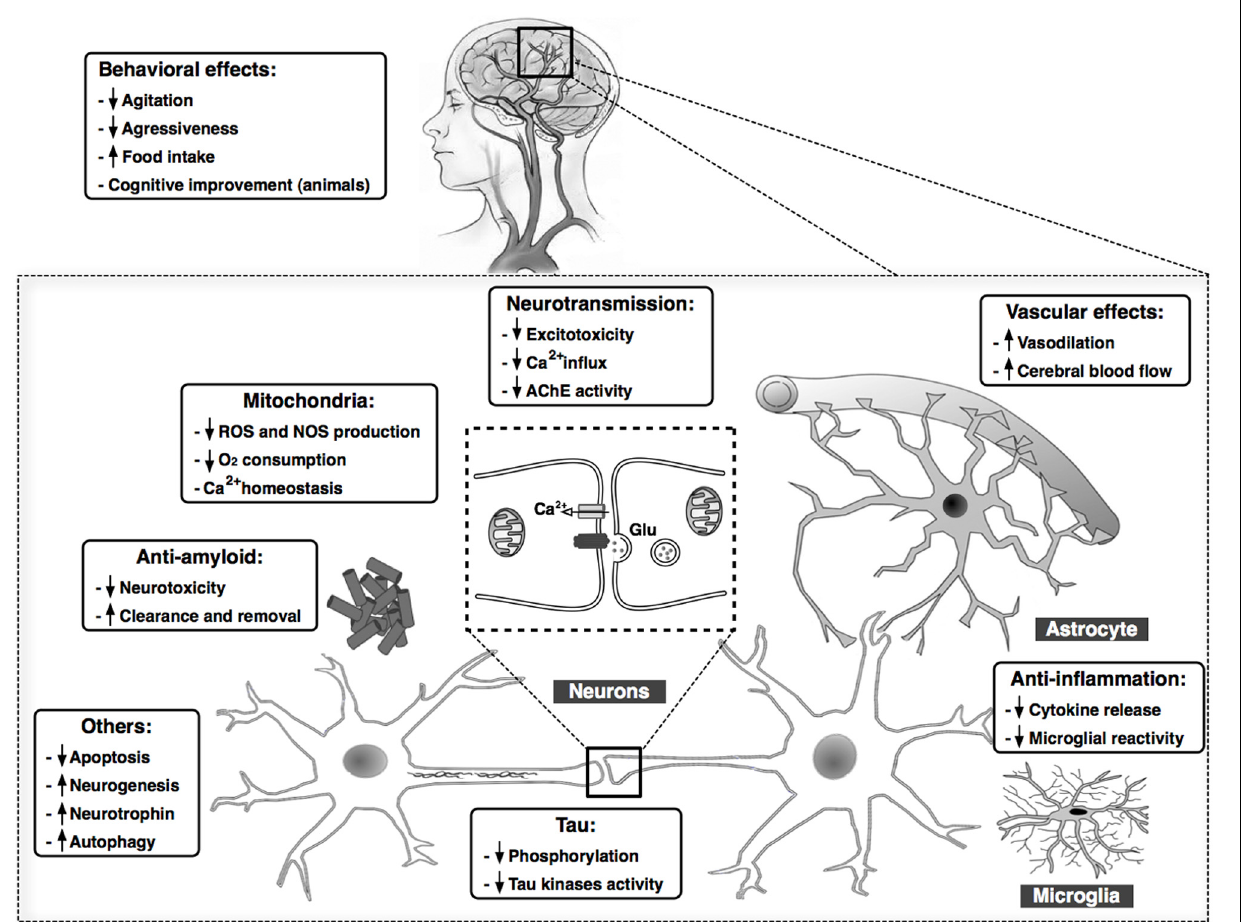
FIGURE 1 | Summary of the main findings demonstrating beneficial effects of cannabinoid compounds in AD models. Cannabinoids may target in parallel several processes that play key roles in AD, including A β and tau aberrant processing, chronic